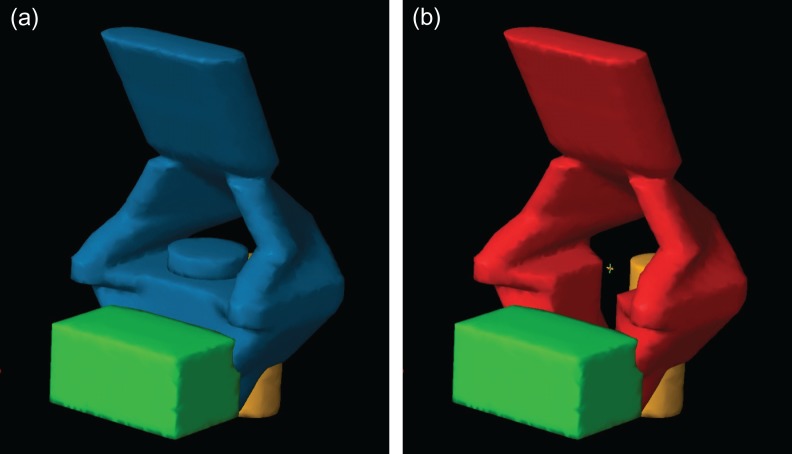
Planning target volumes (PTVs) and organs at risk used for the phantom study: (a) the PTV for whole-pelvis irradiation (PTV-WPphantom) is shown in blue, with the bladder (green) and rectum (yellow); and (b) the PTV for pelvis irradiation with central-shielding (PTV-CSphantom) is shown in red, with the bladderphantom (green) and rectumphantom (yellow).